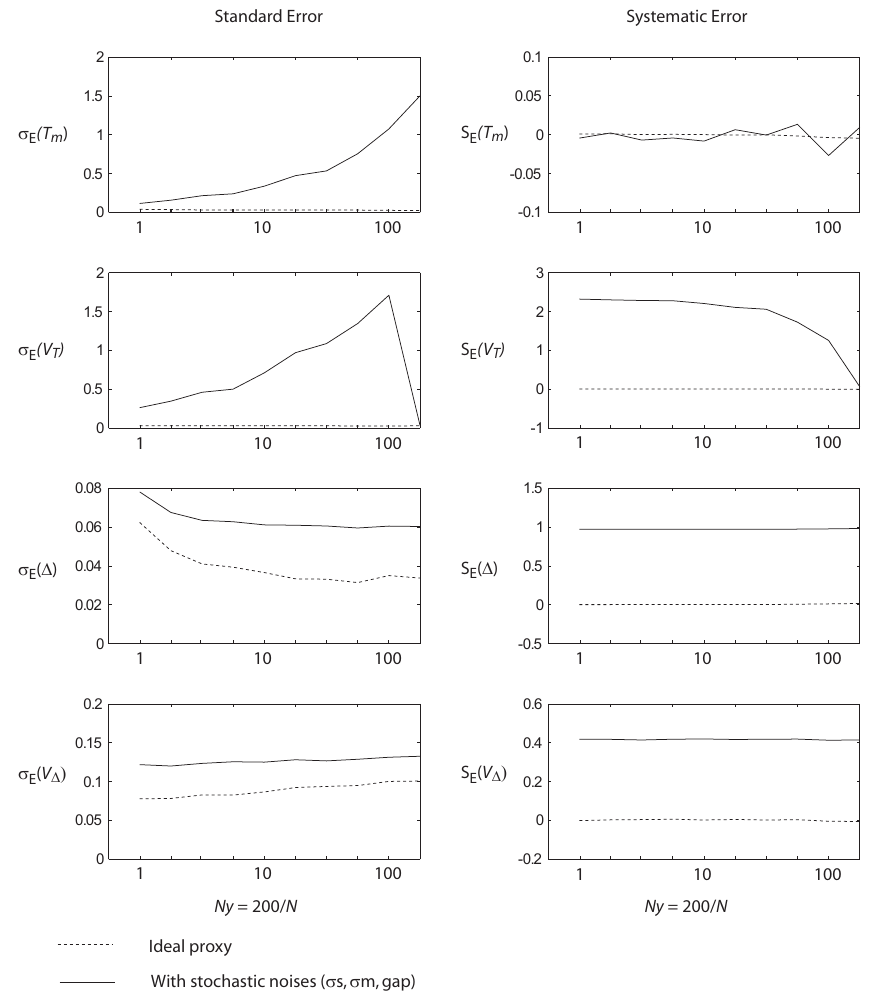
Fig. 3. Results of experiment 2 with the 1950–2009 Ni˜no1+2 SST time series. Standard error (left panel) and systematic error (right panel) obtained for the reconstruction of T m , V T , 1 , and V 1 using the MoCo algorithm, versus the length (number of years) of the proxy record, considering a constant number of 200 recorded years (from 200 one-year old shells to one 200-years old shell). Results using an ideal proxy (dotted line) were compared to results involving stochastic noise (black